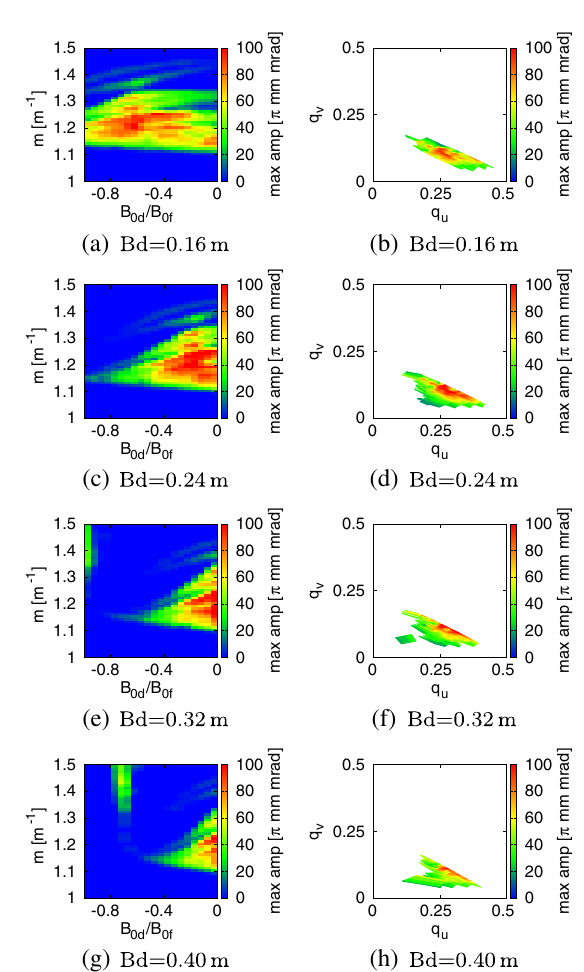
=B 0 space (a, c, e, g) and in d f